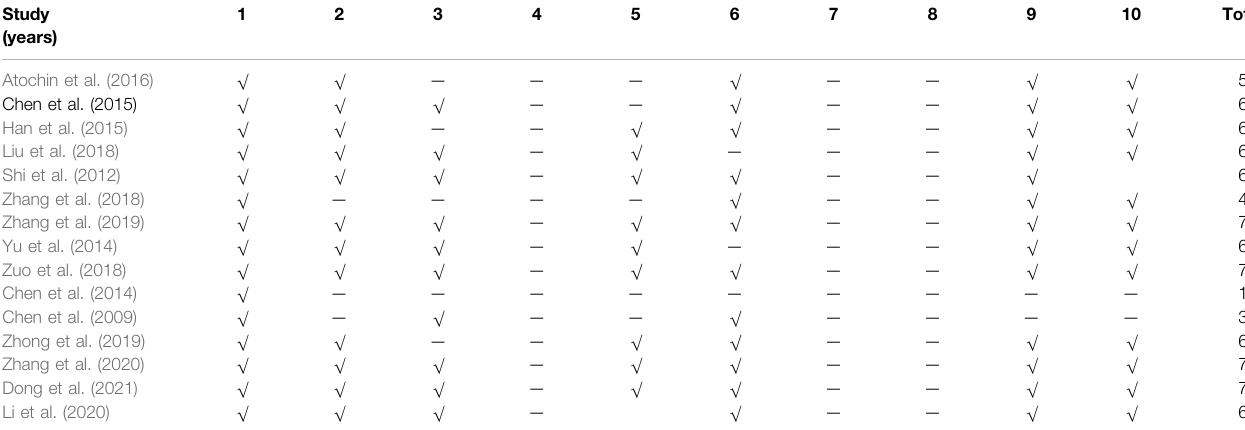
TABLE 2 | Quality assessment of included